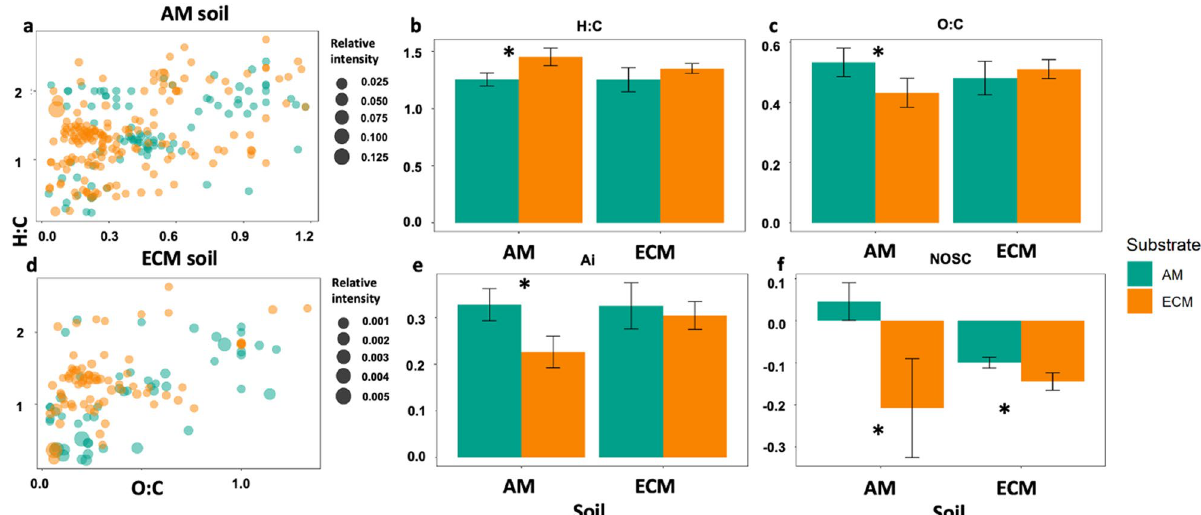
Figure 4. Impacts of substrate incubations on soil organic matter chemistry. Van Krevelen diagrams showing molecular formulae of compounds that are unique to each substrate addition and soil combination in ( a ) AM soil and ( d ) ECM soil. Bar plots depicting mean ± standard error of aggregated indices showing differences in the physicochemical properties, ( b ) H:C ratio, ( c ) O:C ratio, ( e ) aromaticity index (Ai), and ( f ) Nominal Oxidation State of C (NOSC), of the SOM pool. Error bars indicate standard error (n = 5). Asterisks denote differences between substrate types in each soil at p <